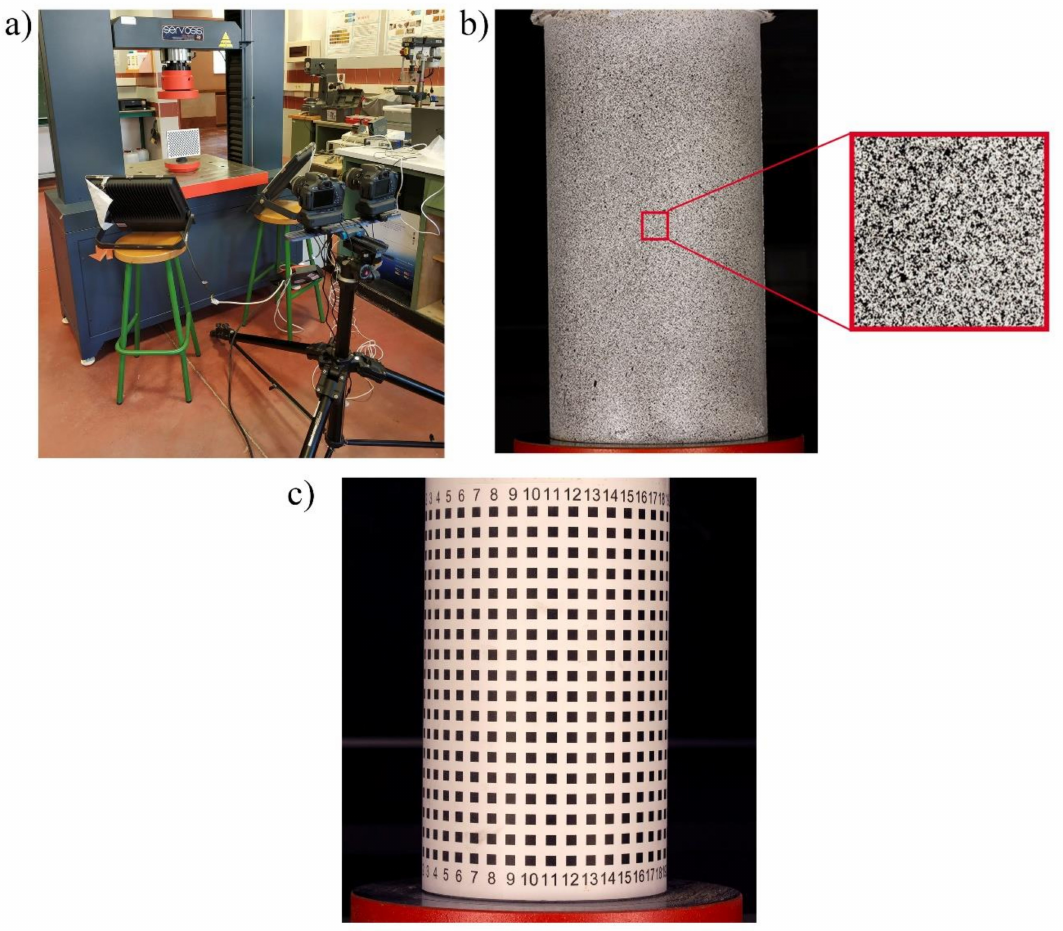
Figure 7. Digital Image Correlation campaign: ( a ) set-up used at the calibration stage; ( b ) detail of the speckle pattern applied; and ( c ) cylindrical calibration